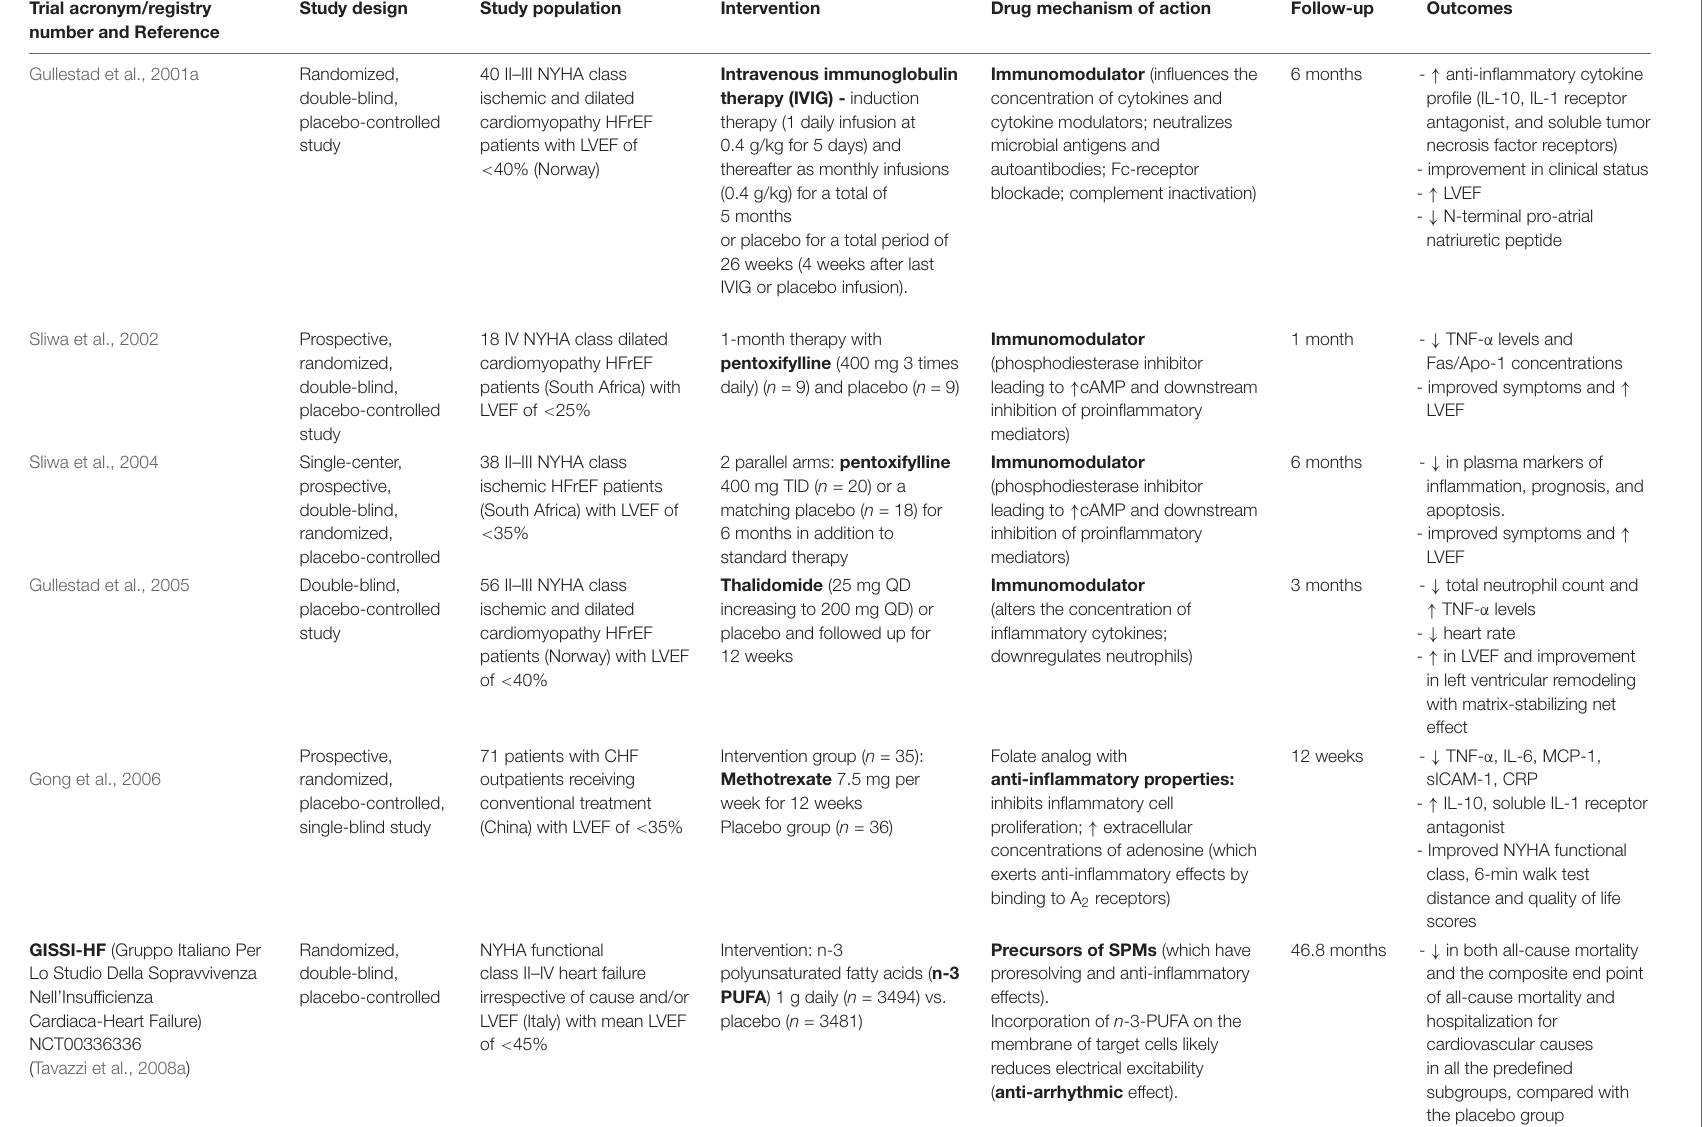
TABLE 2 | Other anti-inflammatory trials in